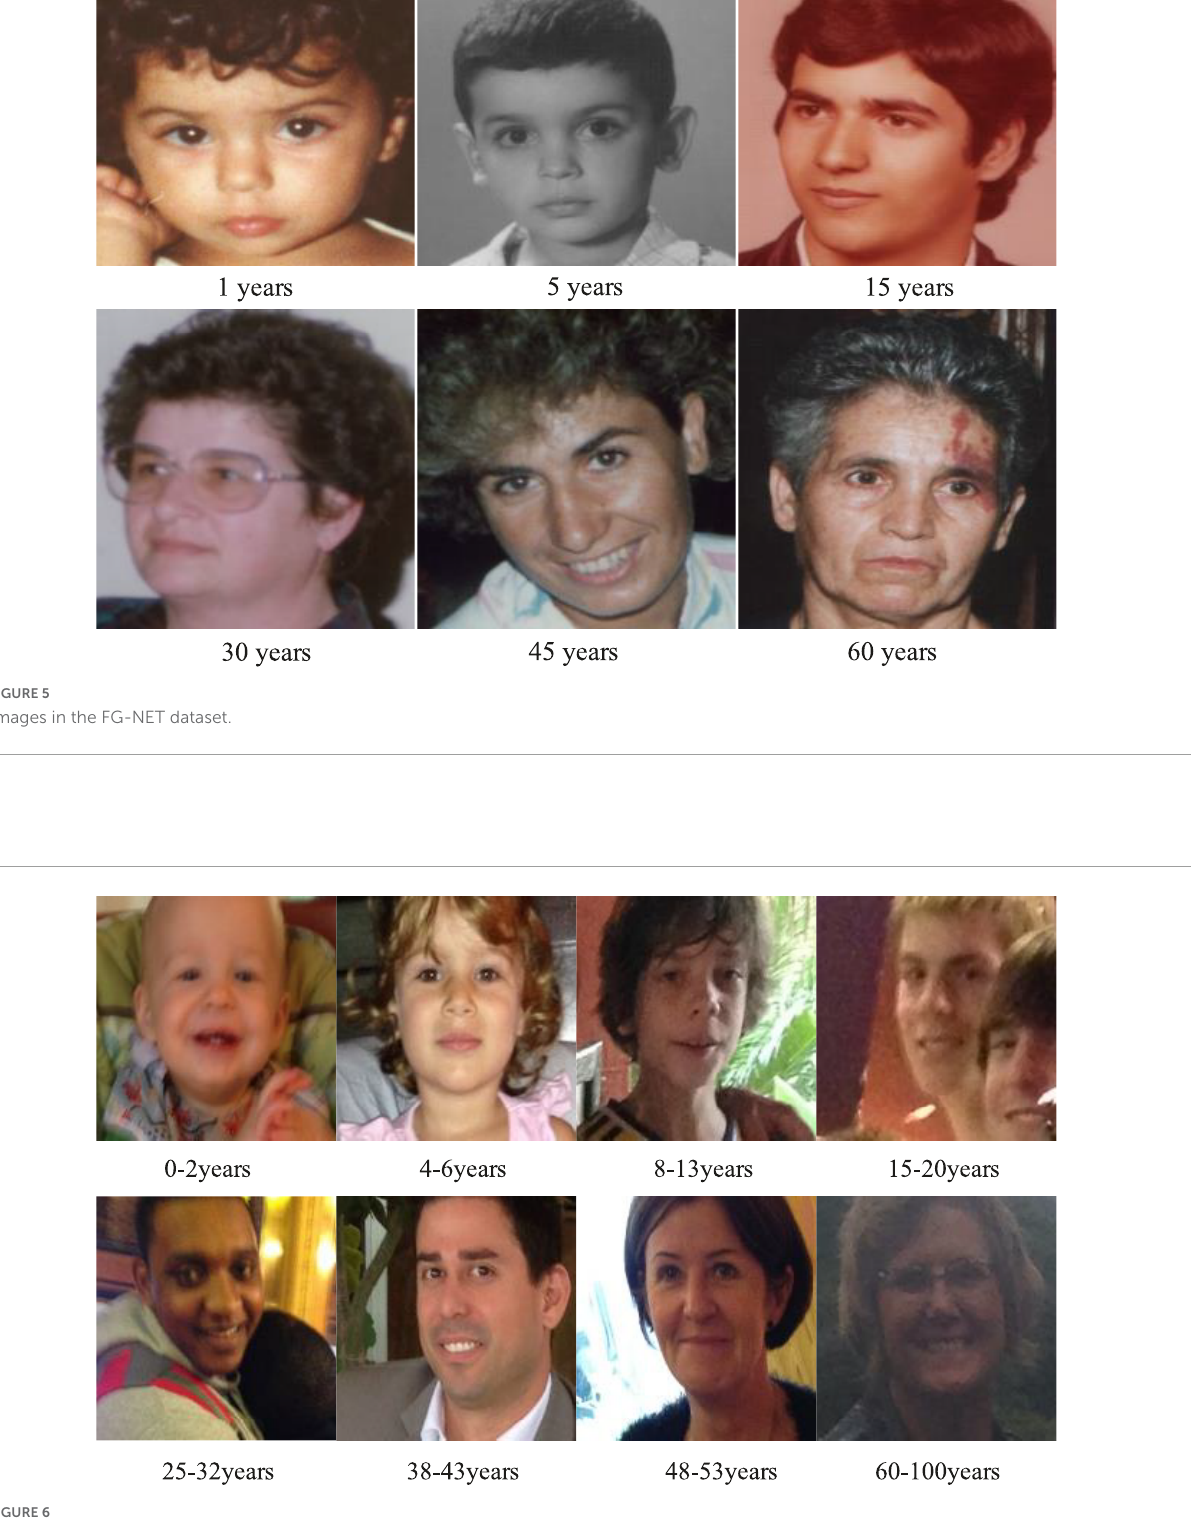
FIGURE6 Images in the Adience